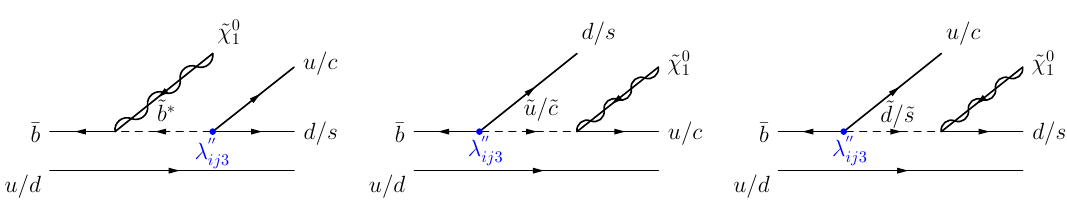
1 Figure 1 . Parton-level diagrams for the decays B → B ˜ χ 0 ); Λ + , Σ + , Σ 0 (for c c c 123